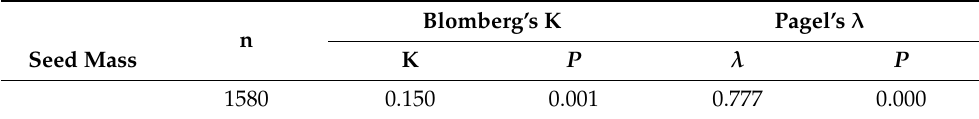
Table 1. Phylogenetic signals (Blomberg’s K and Pagel’s λ ) of seed mass. n